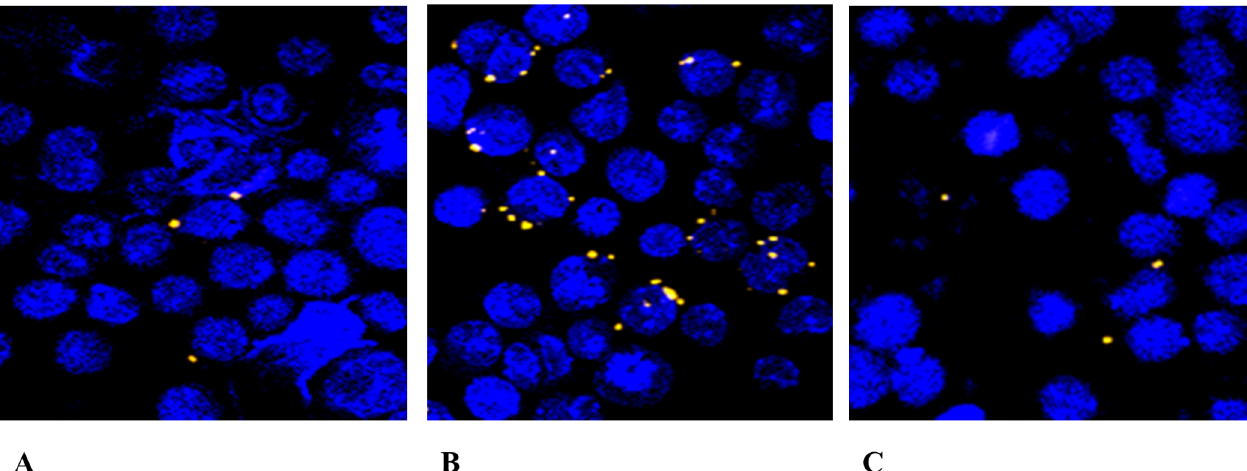
Fig 1. Fluorescent microscopy. The representative picture was chosen to show the difference in the numbers of A20 cells infected with (A) unopsonized F . tularensis LVS/GFP bacteria, (B) F . tularensis LVS/GFP opsonized with murine fresh serum, and (C) bacteria opsonized with immune sera. A20 cells in total volume 0.5 mL (1 x 10 6 cells per well) were infected with F . tularensis LVS/GFP at MOI 500 for 3 h. The cell nuclei were stained with DAPI. Note: The number of infected cells was counted using flow cytometry.